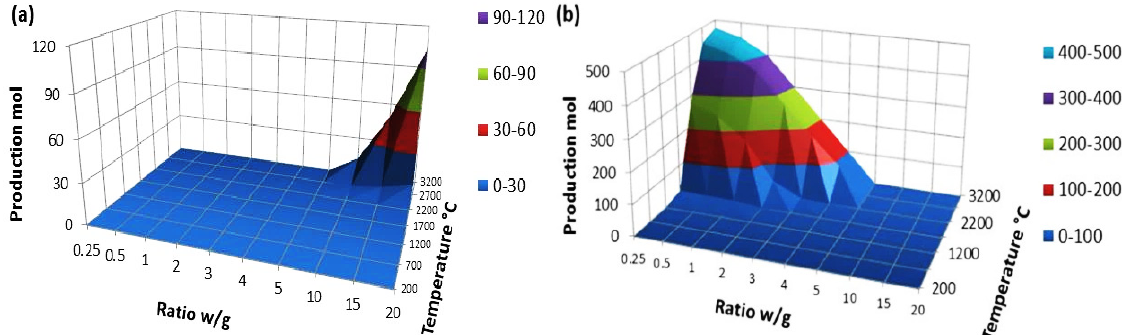
Figure 4. Production of ( a ) oxygen and ( b ) carbon as graphite at 0.1